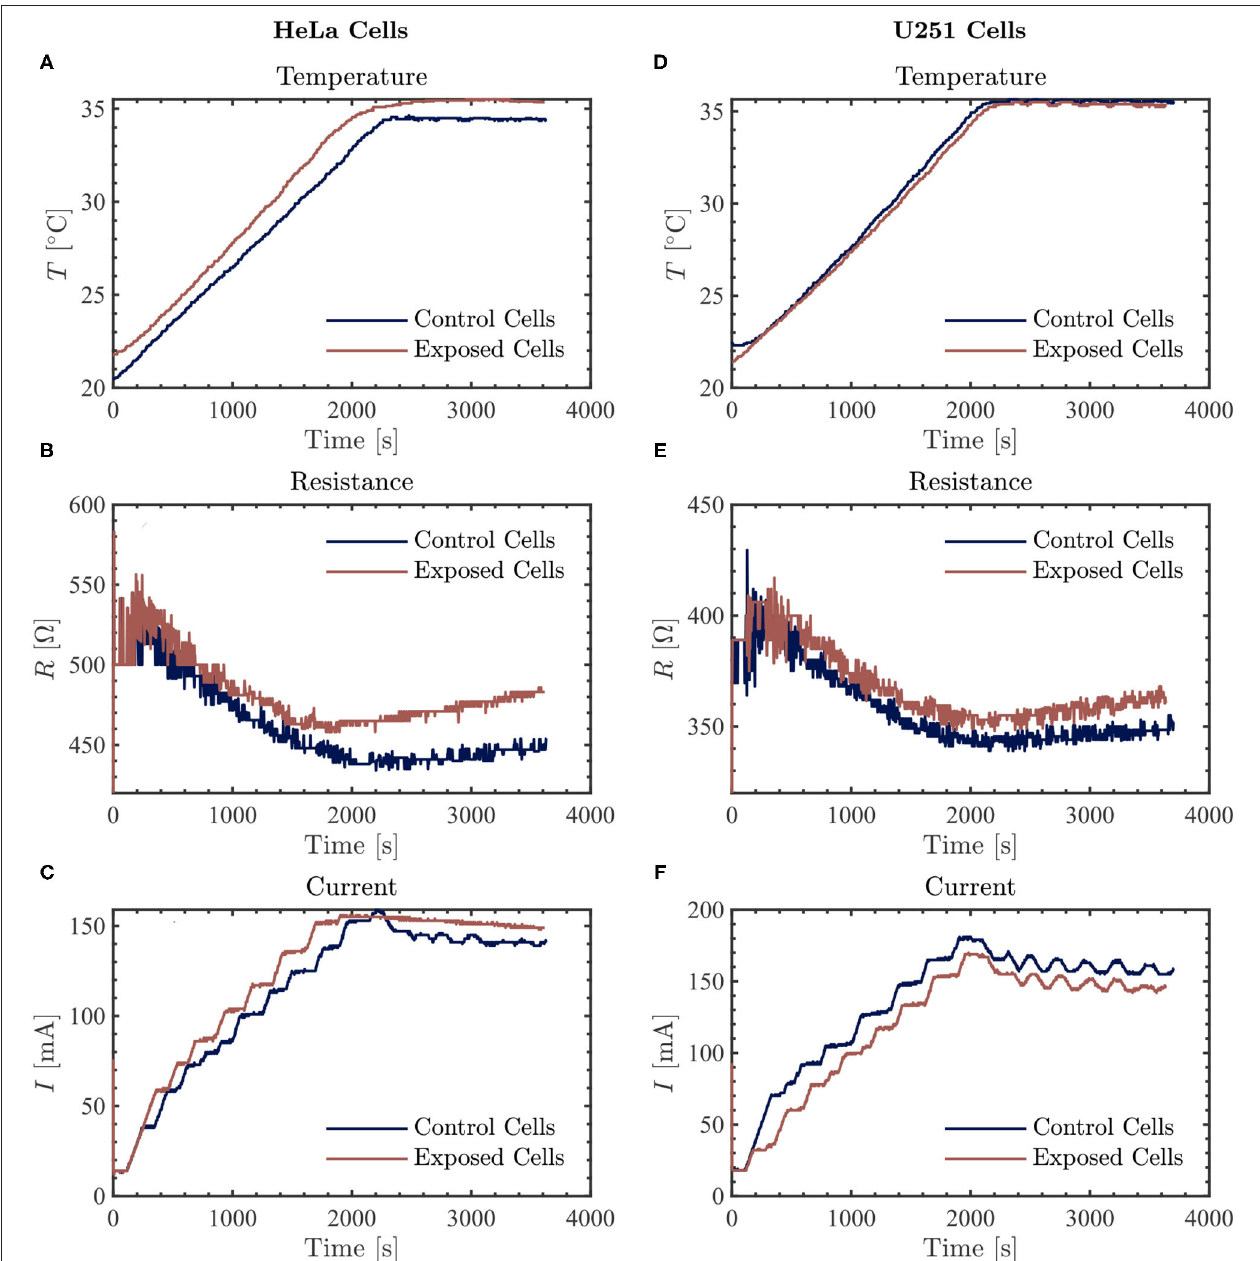
FIGURE 3 | The resulting average temperature (top), resistance (middle), and current (bottom) graphs measured by the inovitro live software for 50 kHz TTFields applied to HeLa (left, A–C ) and U251 (right, D–F ) cells in the absence (control) or presence of Vielight LED exposure for 1 h with the software settings as described in the text. The control and Vielight LED-exposed results are shown in blue and red, respectively. Data shown for both cell lines are taken from a single independent experiment out of N = 2 (for HeLa) and N = 1 (for U251) total replicate experiments